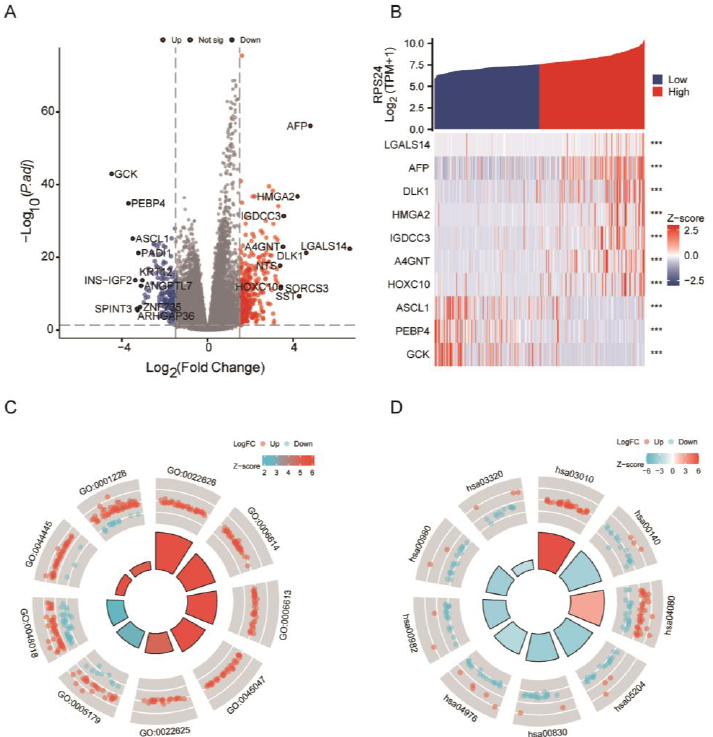
Figure 5. Identification of DEGs and PPI network Analysis. ( A )Volcano plot of the DEGs of RPS24, depicting the top 10 up- and down-regulated DEGs. ( B ) The relationship between the top 10 DEGs (including LGALS14, DLK1, AFP, HMGA2, IGDCC3, A4GNT, HOXC10, ASCL1, PEBP4, and GCK) and RPS24 was analyzed. ( C , D ) GO and KEGG pathway enrichment analyses of the DEGs of RPS24 were performed. *** p <